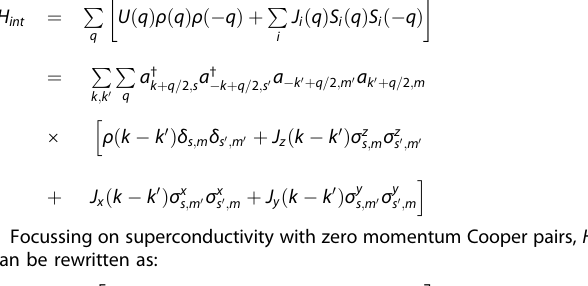
Table 2. Data availability